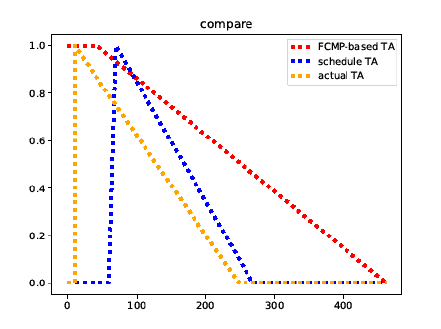
Fig. 7. Comparison of FMFs of the actual, schedule and calculated TA